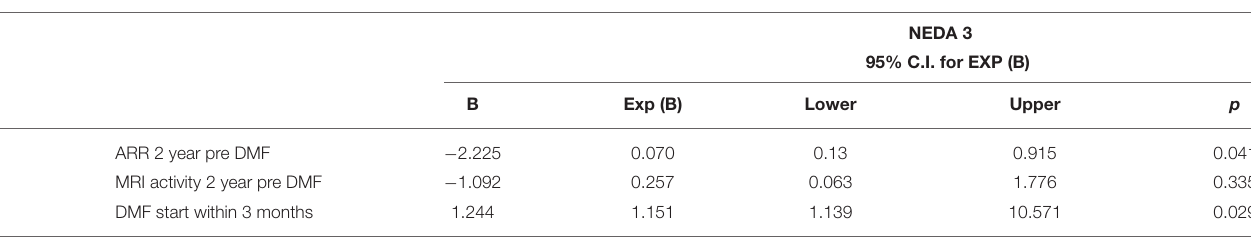
TABLE 5 | NEDA 3. Predictors of DMF efficacy after de-escalation